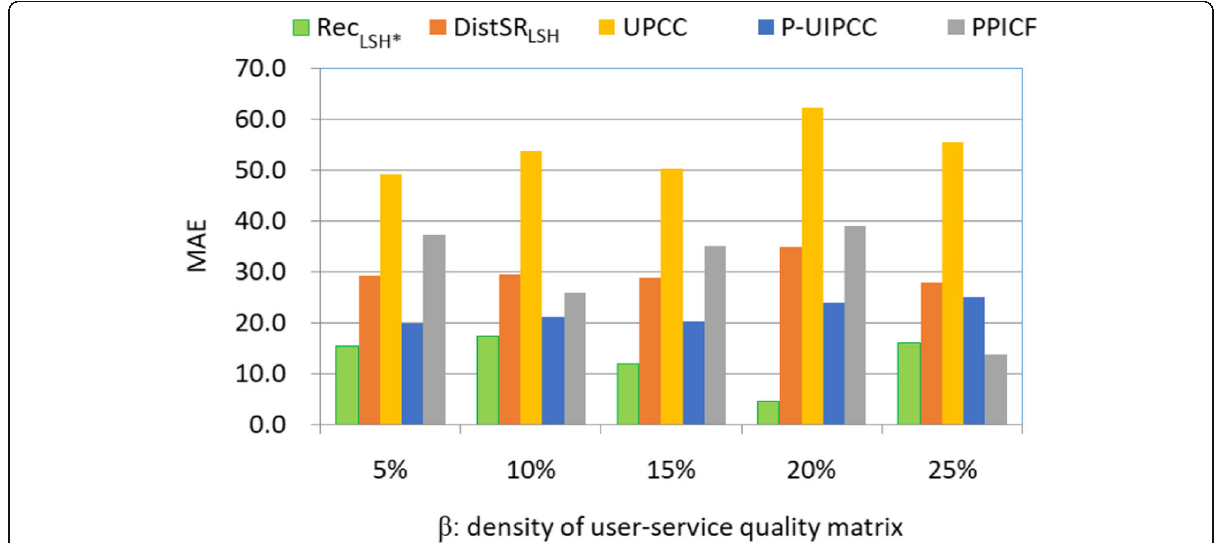
Fig. 1 Recommendation accuracy comparison (w.r.t. β ). Detailed legend: Rec LSH* , DistSR LSH , UPCC , P-UIPCC ,